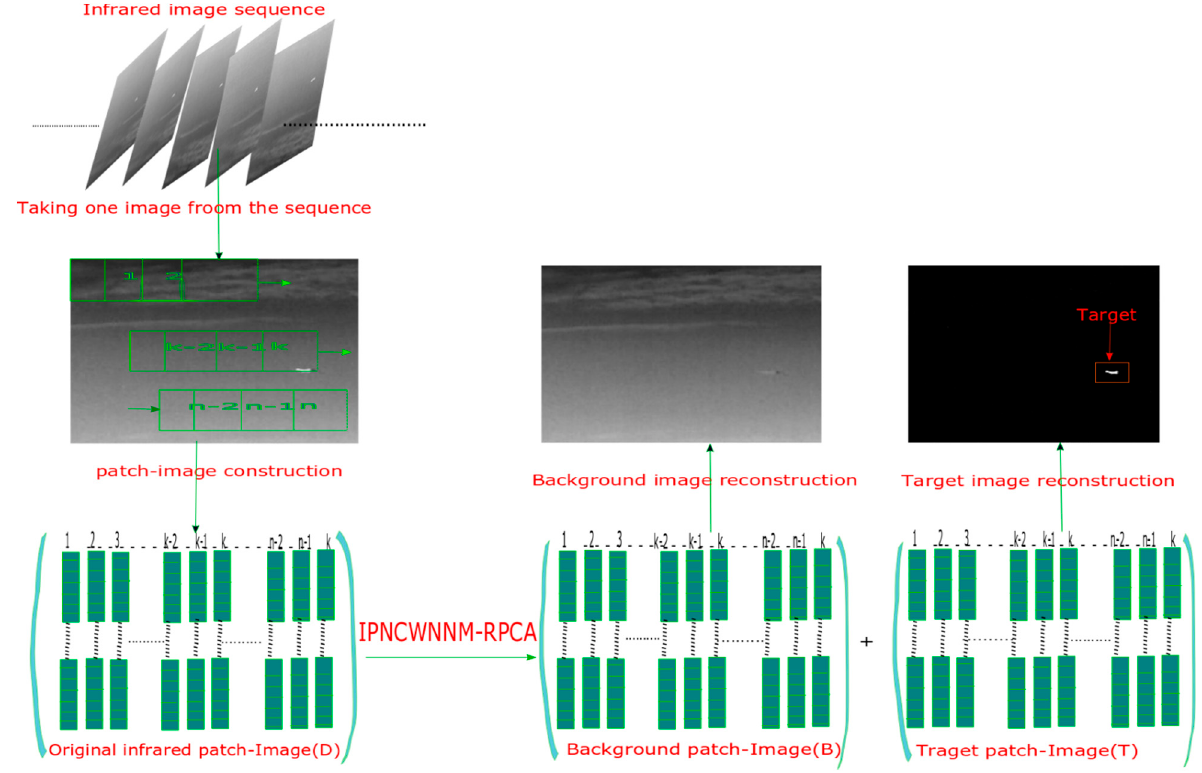
Figure 2. The proposed IPNCWNNM–RPCA model’s process.